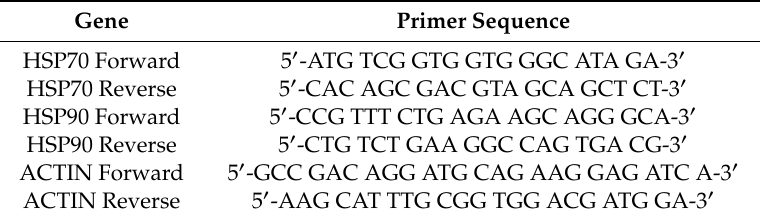
Table 1. Primer sequences used for qRT-PCR in this study.